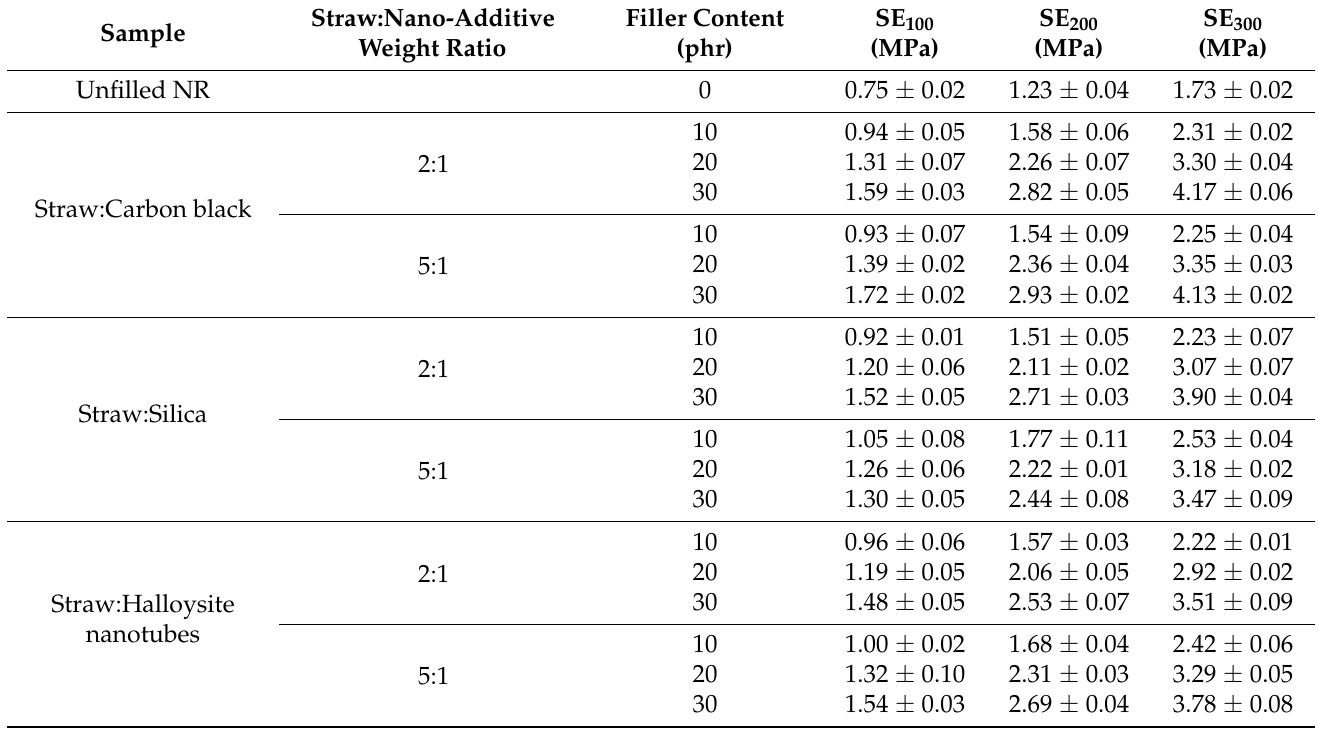
Table 5. Mechanical properties of vulcanizates.